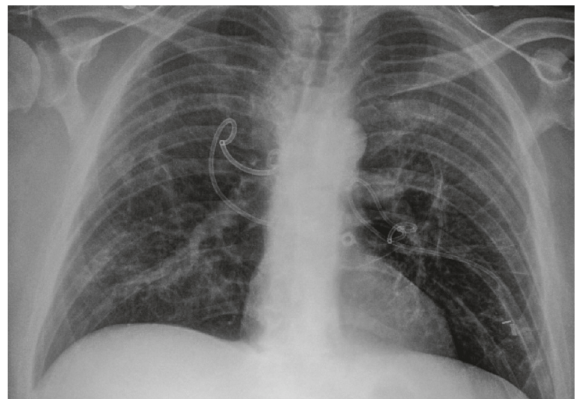
Figure 4: Anteroposterior chest radiograph taken 1 week after chest tube